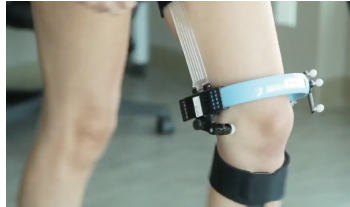
Figure 2. The KneeKG system